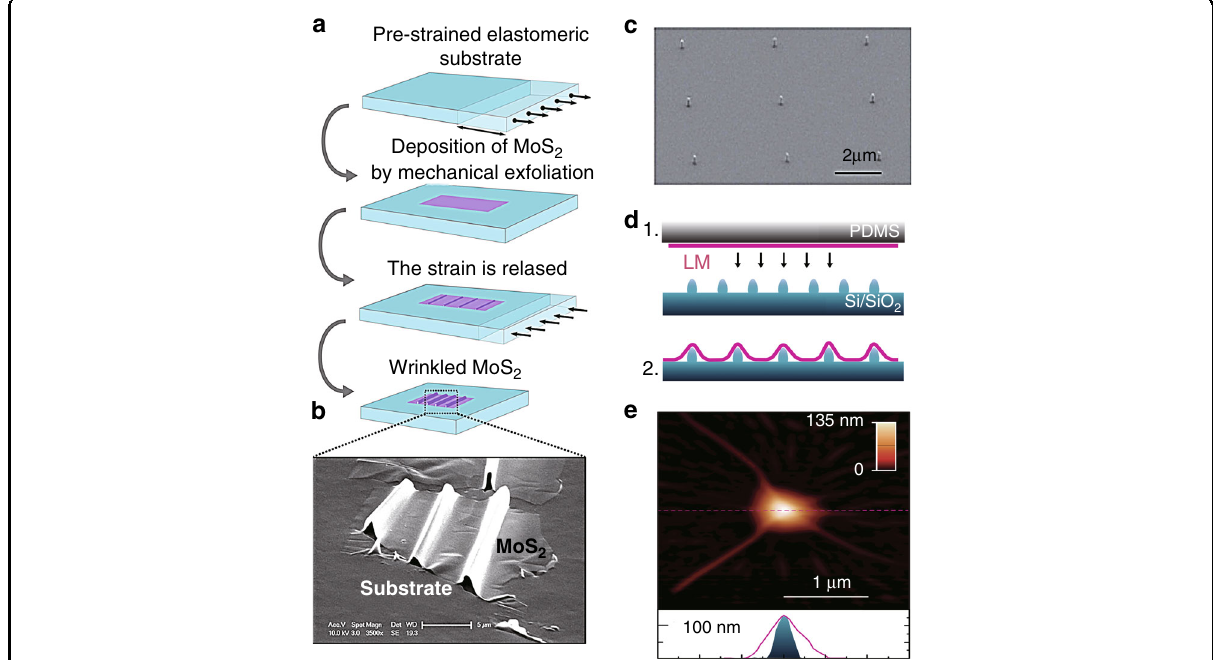
Fig. 9 Wrinkling and nanostructure support for local strain generation. a Schematic of the formation of wrinkled 2D MoS 2 (ref. 41 ), and b optical microscopy image of a wrinkled MoS 2 sheet 41 . c , d SEM micrograph of an array of silica nanopillars on a silicon substrate and d fabrication procedures for a layered material (LM) on the nanopillars 126 . e AFM image of monolayer WSe 2 on a silica nanopillar (upper panel), and height pro fi les of the nanopillar before (blue area) and after (pink line) LM deposition (lower panel) 126 . Reprinted a and b with permission from ref. 41 . Copyright